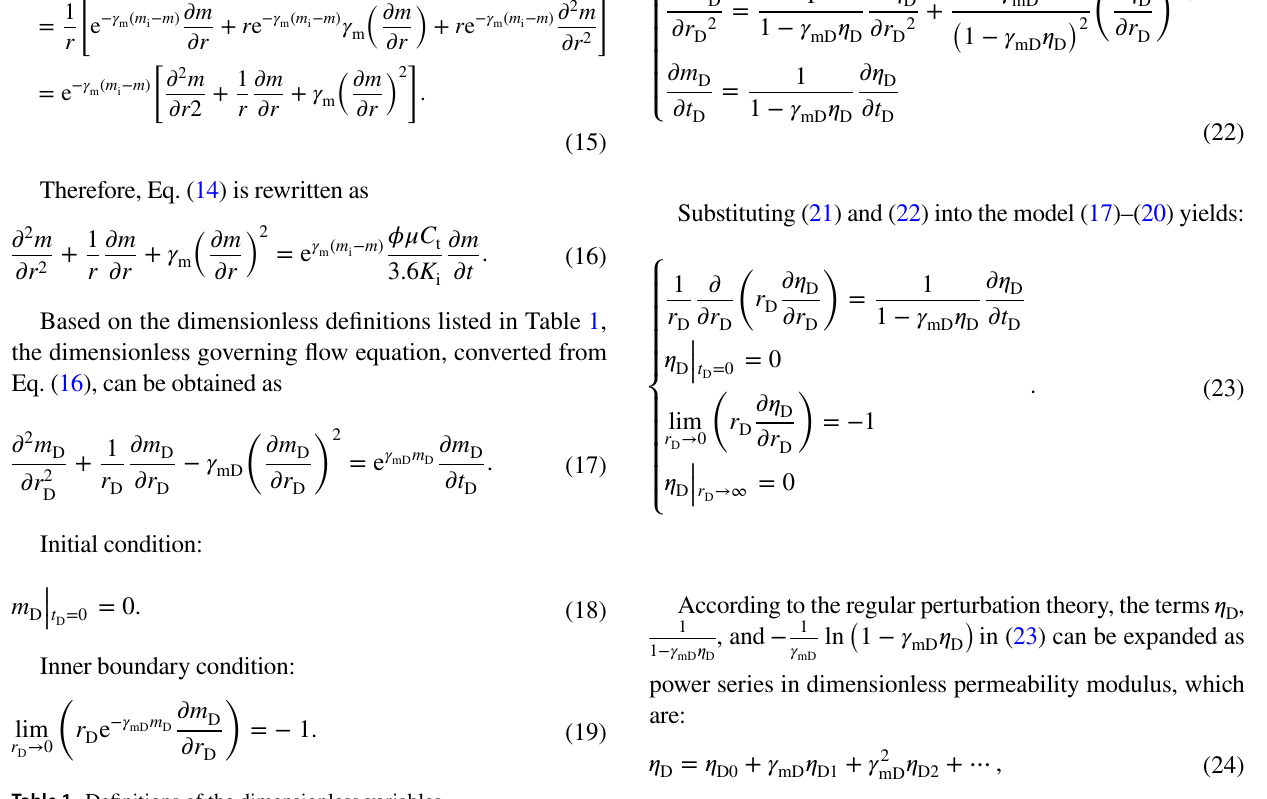
Table 1 Definitions of the dimensionless variables Dimensionless pseudo